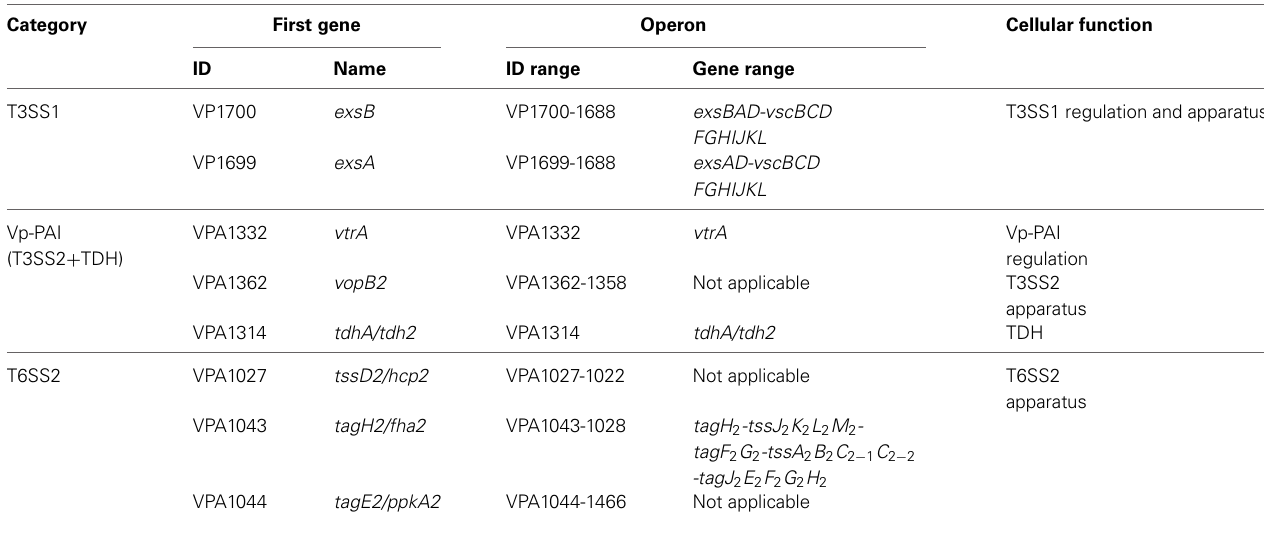
Table 1 | Direct H-NS targets characterized in this